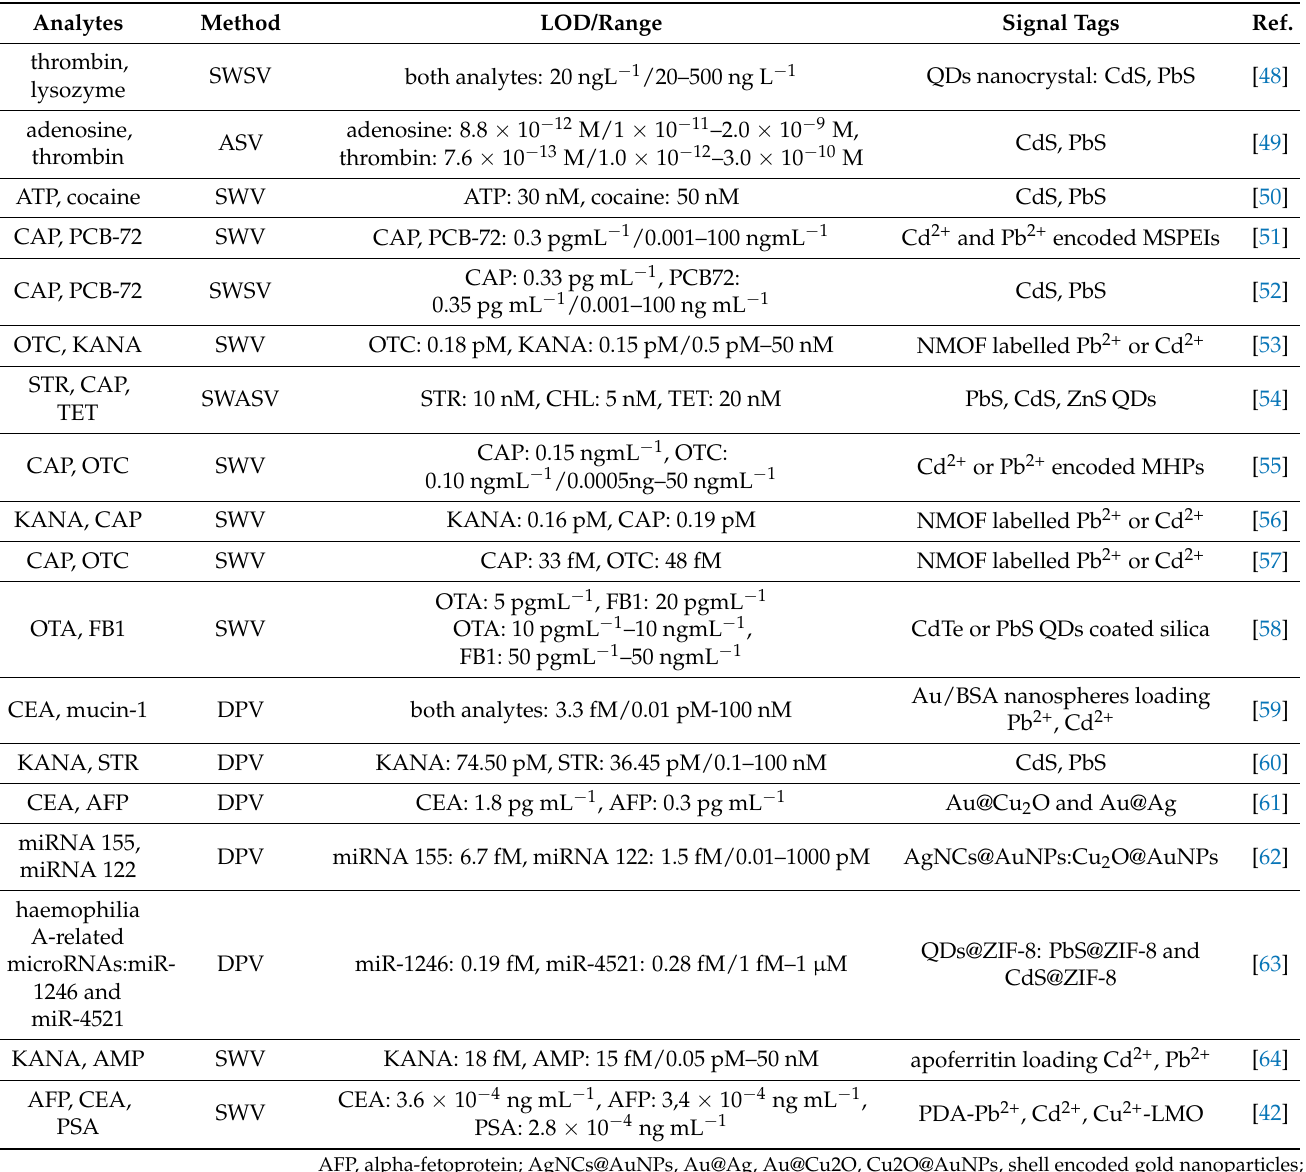
Table 1. Multiplex electrochemical aptasensors based on quantum dots, metal compound semicon- ductor NPs, and metal ions.